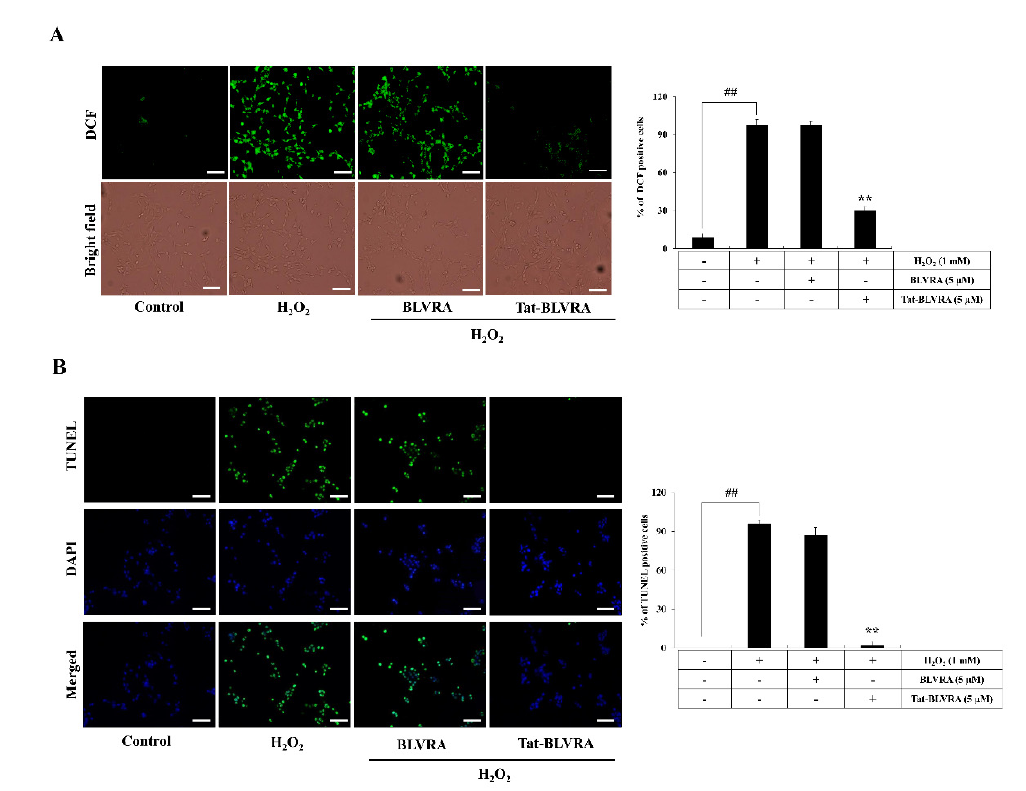
Figure 3. Effect of Tat-BLVRA protein against H 2 O 2 -induced cellular toxicity. Tat-BLVRA or